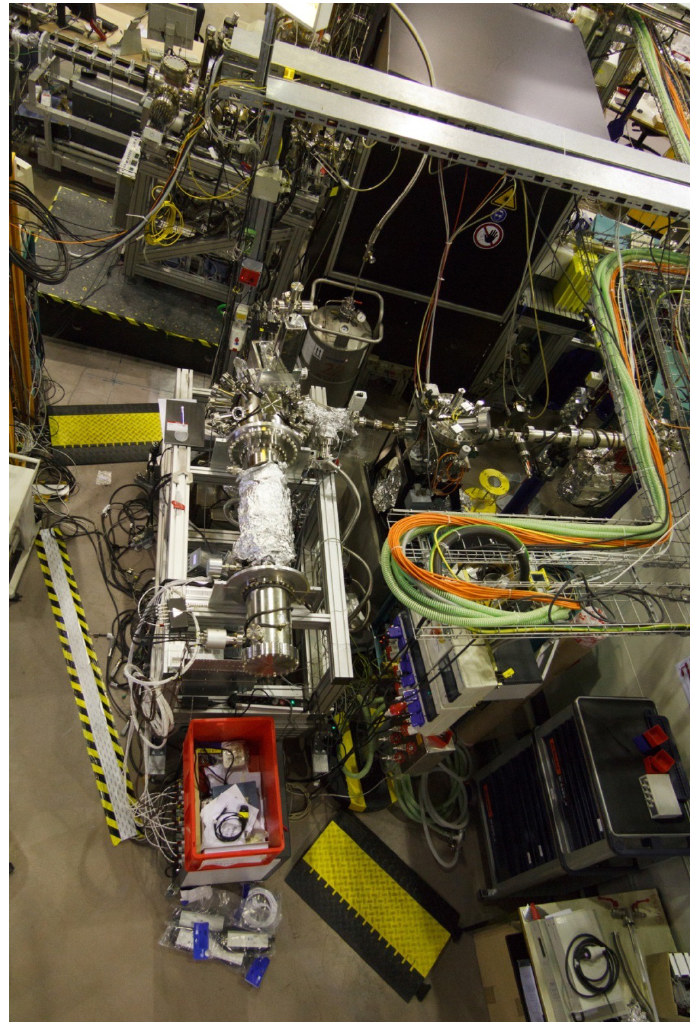
Figure 2: On-top view on the FEMTOSPEX Molecules and Surfaces